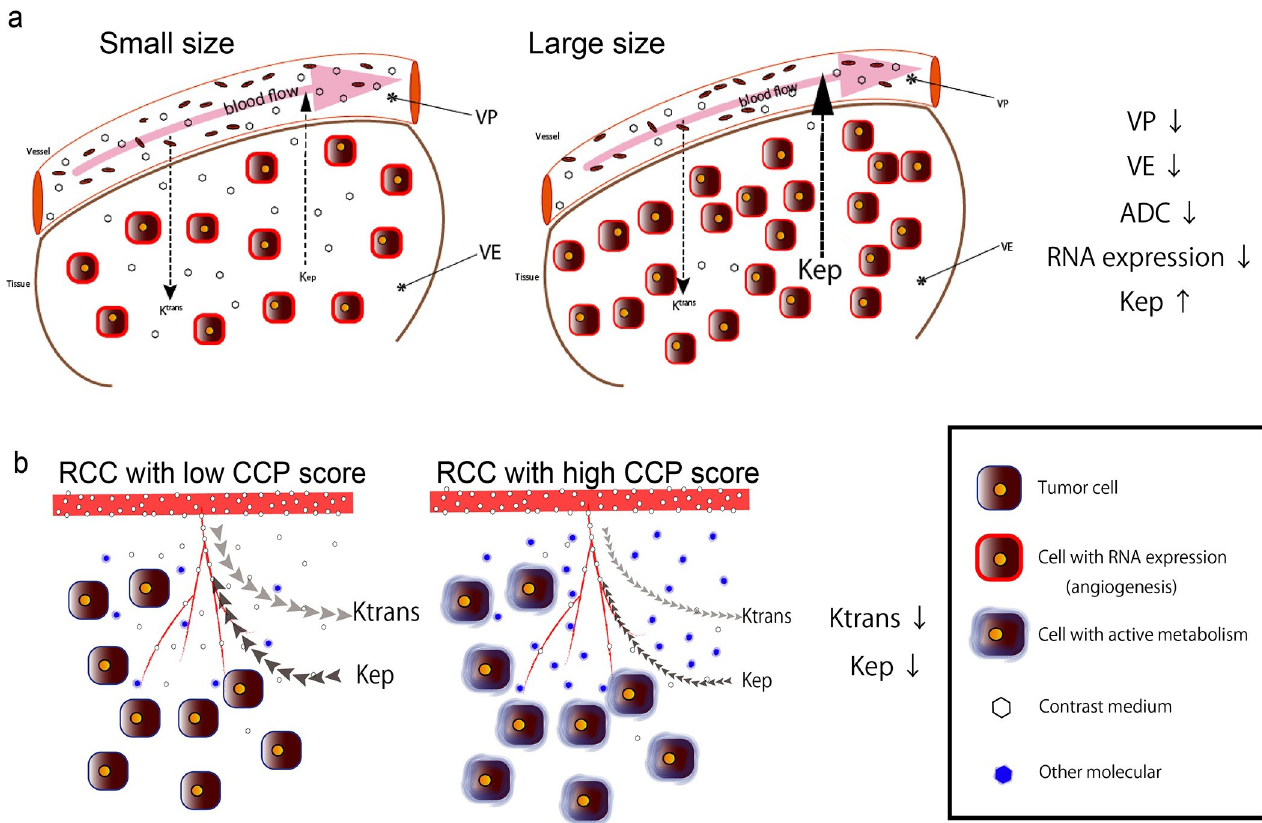
Fig 6. Consideration of the molecular pathogenesis in small RCC. a: Schema of the relationships among the tumor size, RNA expression, and imaging parameters. Low perfusion and increased cell density occur with tumor growth. b: Schema of the relationships between the CCP score and the perfusion parameters. RCCs with a high CCP score developed a more aggressive tumor microenvironment, resulting in reduced permeabilities.